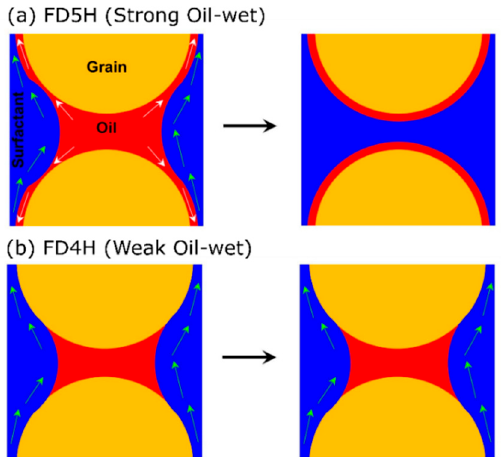
Figure 7. The hypothetical configuration of residual oil phase in ( a ) strong oil-wet core sample FD5H, and ( b ) weakly oil-wet core sample FD4H during surfactant flooding.